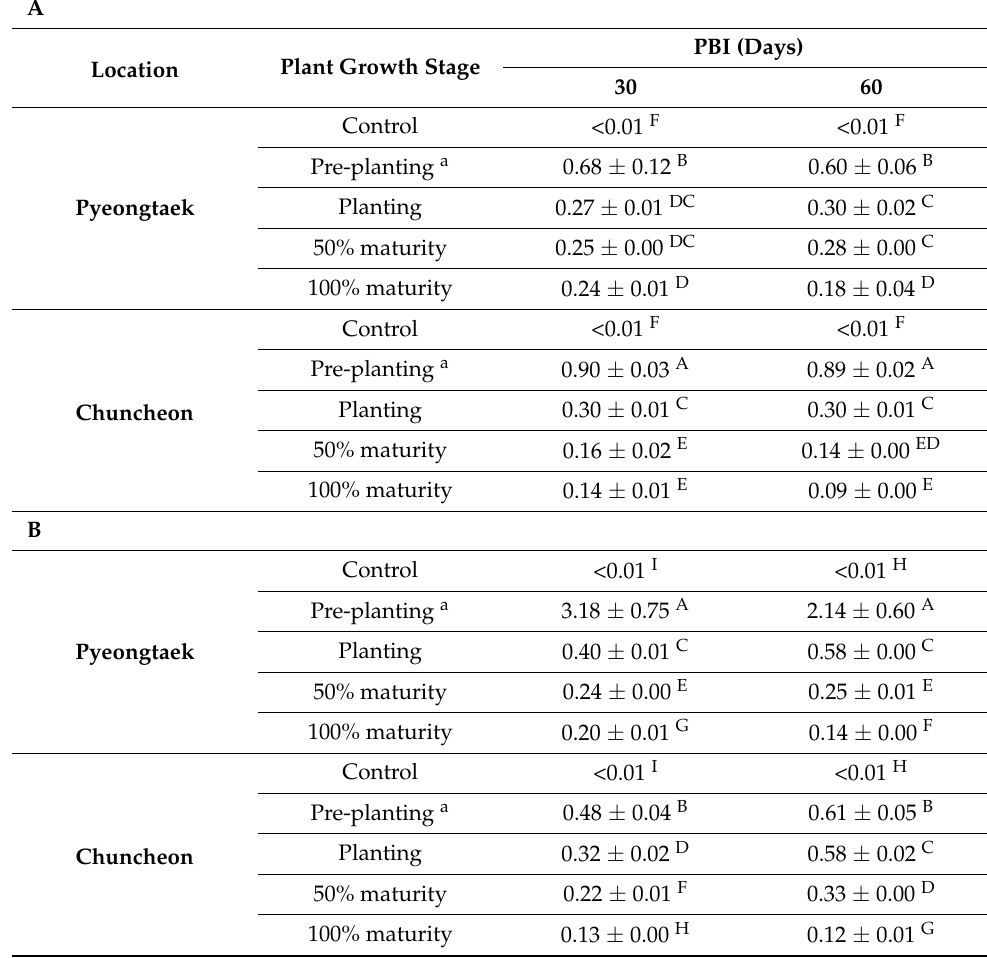
Table 2. Dinotefuran total a) residues (mg/kg *) remaining in soils samples of ( A ) lettuce and ( B )